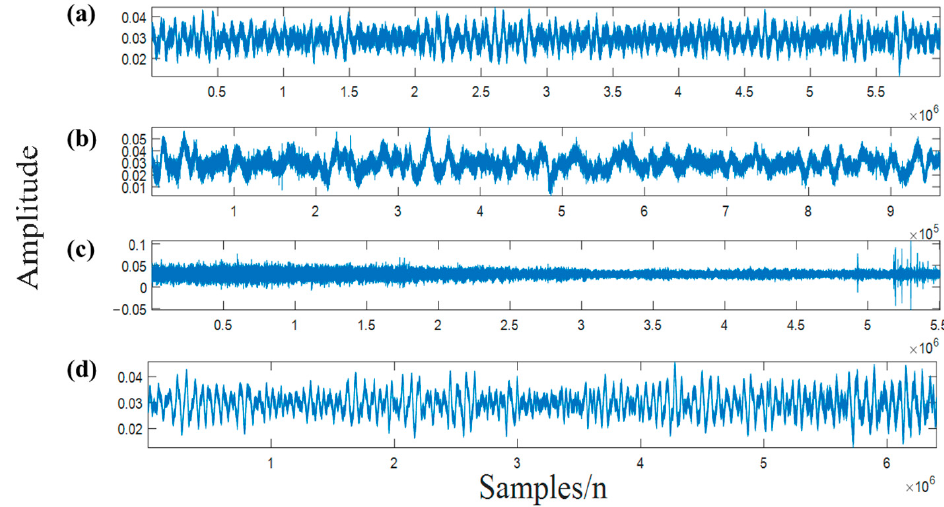
Figure 10. Raw radiated noise from four different types of ships: ( a ) cargo; ( b ) passenger ship; ( c ) tanker; ( d ) tug.